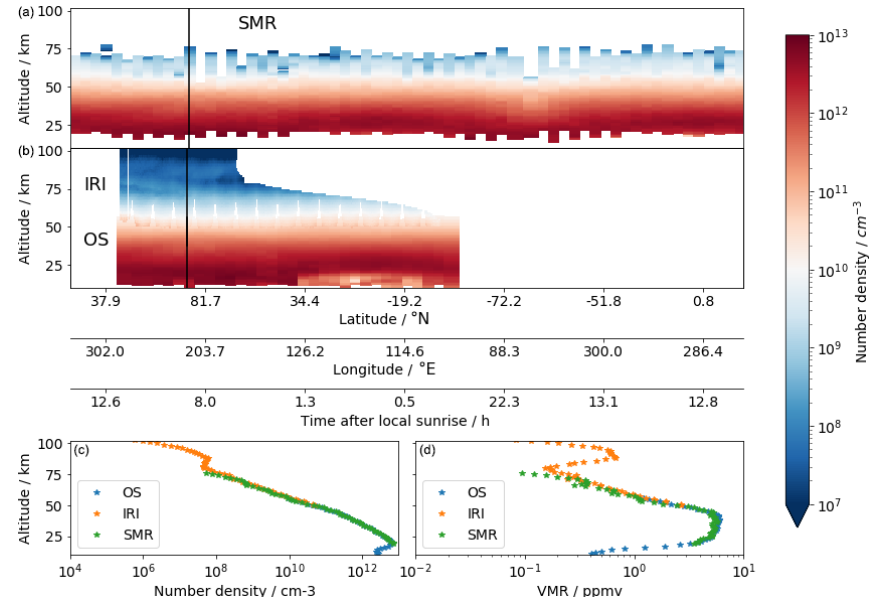
Figure 11. (a) A 2D colour plot of SMR ozone number density profiles for one orbit as a function of altitude and geographical location collected on 30 March 2008 from 22:14:56 to 23:51:03 (Odin orbit number 38720). (b) A 2D colour plot of IRI (above 50km) and OS (below 60km) daytime ozone profiles corresponding to the same orbit as SMR. (c) Ozone number density profiles from the scan or image of OS, IRI and SMR indicated by the vertical black line in the panels above. (d) The same as (c) but showing the volume mixing ratio in